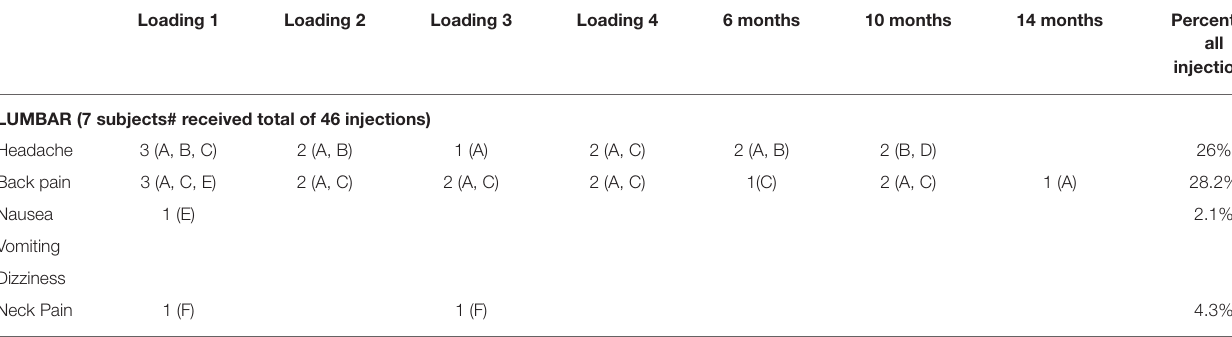
TABLE 2 | Adverse events lumbar injections.